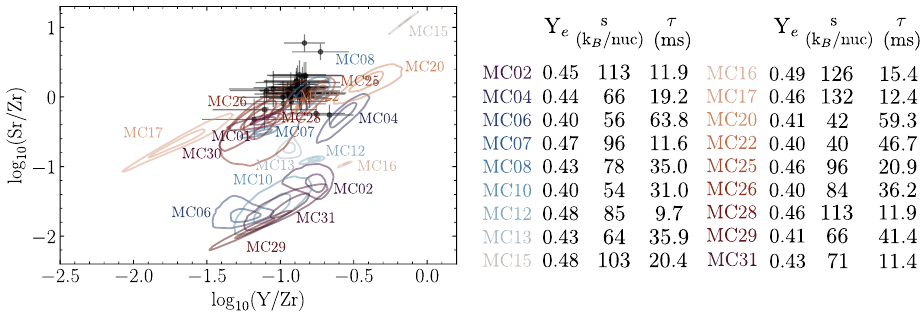
Figure 1. Two-dimensional Kernel Density Estimates (KDEs) of the Sr / Y and Y / Zr elemental ratios from Ref. [6] with the addition of stars from the sample of Ref. [10]. In the right, the main properties of each model (electron fraction Y e , entropy per nucleon s and expansion timescale τ ) are presented. The contours show the 1 and 2 σ uncertainties for each calculation. See the text for